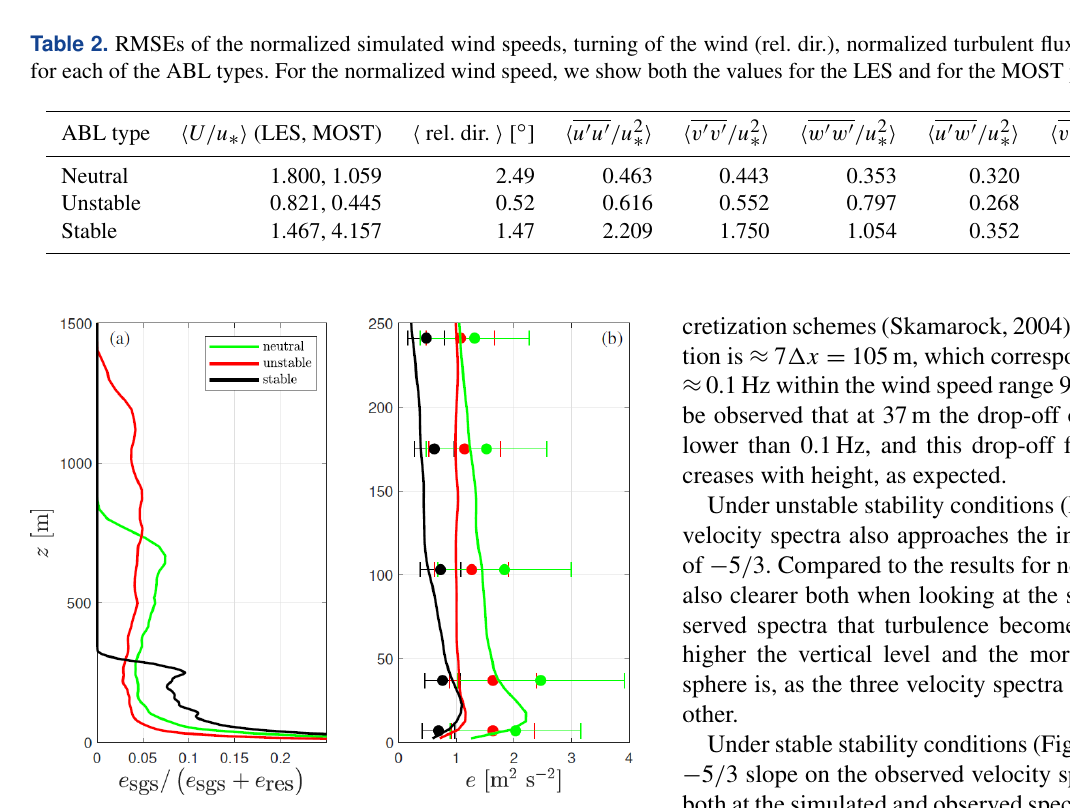
Figure 12. (a) Vertical profiles of the ratio of the subgrid to the total (subgrid plus resolved terms) turbulent kinetic energy from the simulations of the three types of ABLs. (b) Simulated (solid lines) and observed (markers) vertical profiles of total turbulent kinetic energy. The error bars denote ± 1 standard deviation from the mean of the